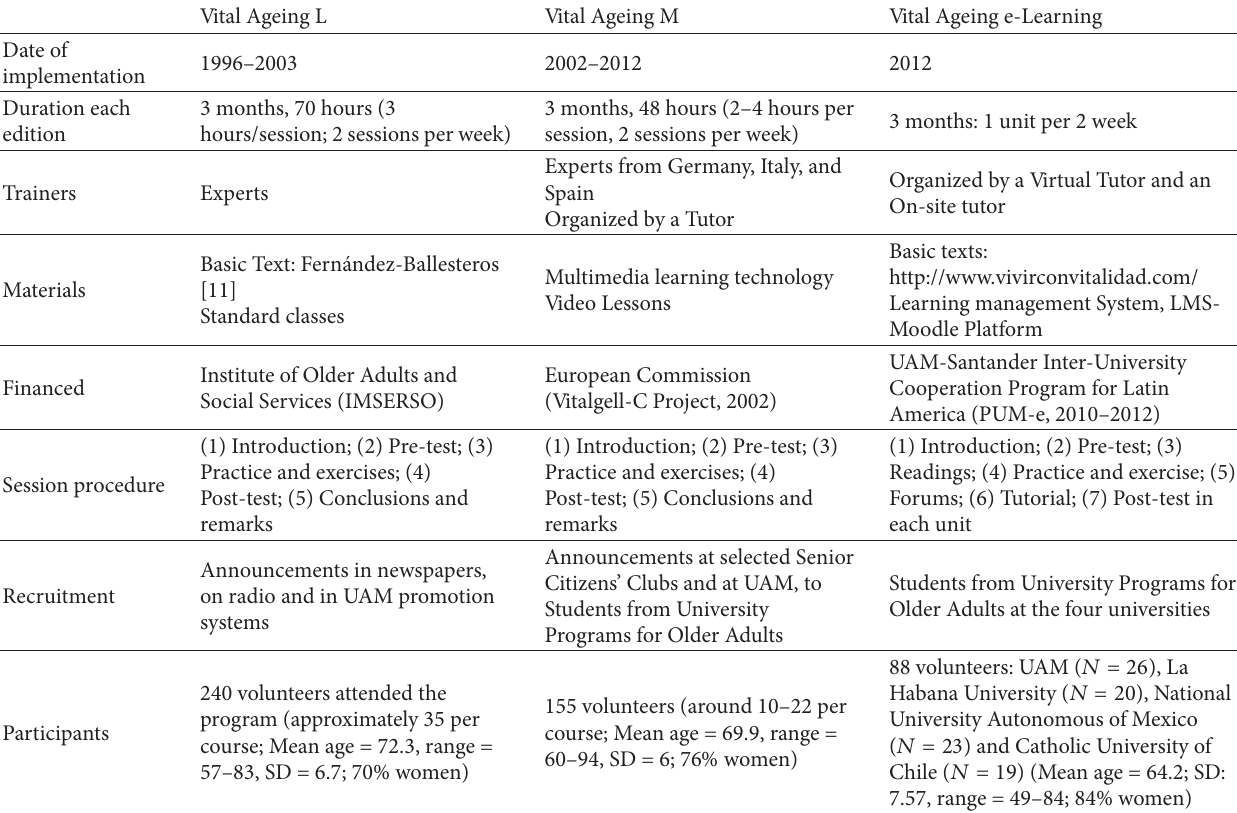
T 1: Summary of Vital Aging versions: procedures for implementation and